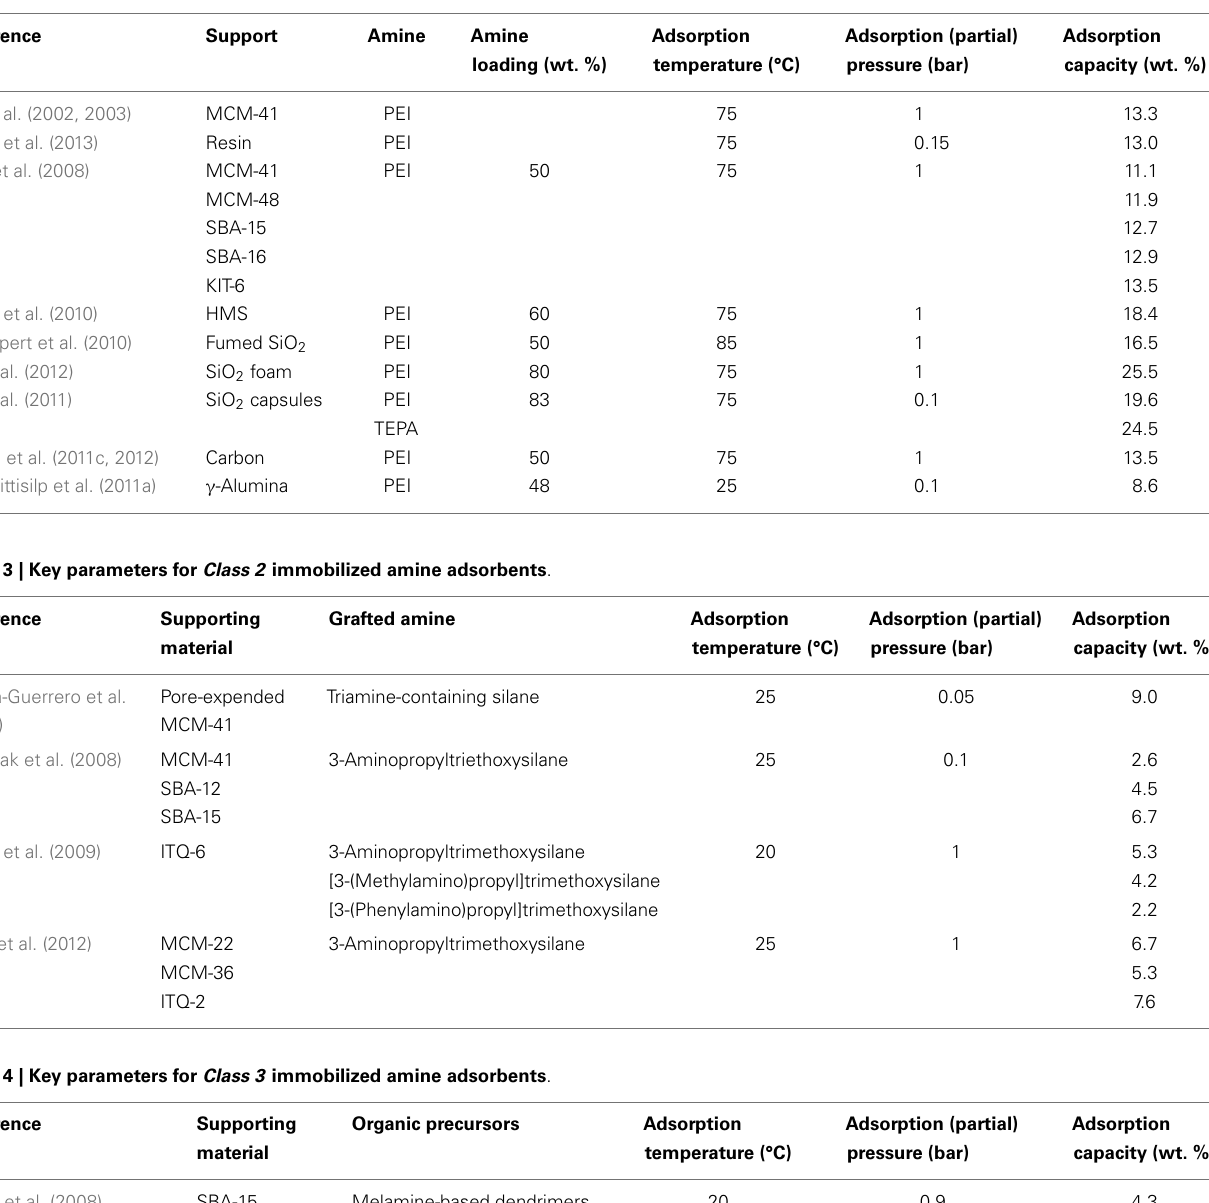
Table 2 | Key parameters for Class 1 immobilized amine adsorbents .